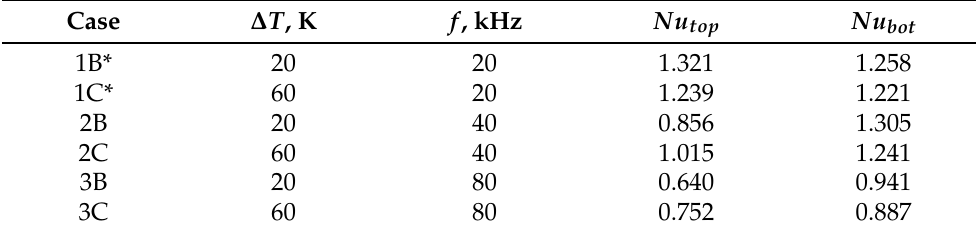
Table 2. Nusselt number at the top and bottom